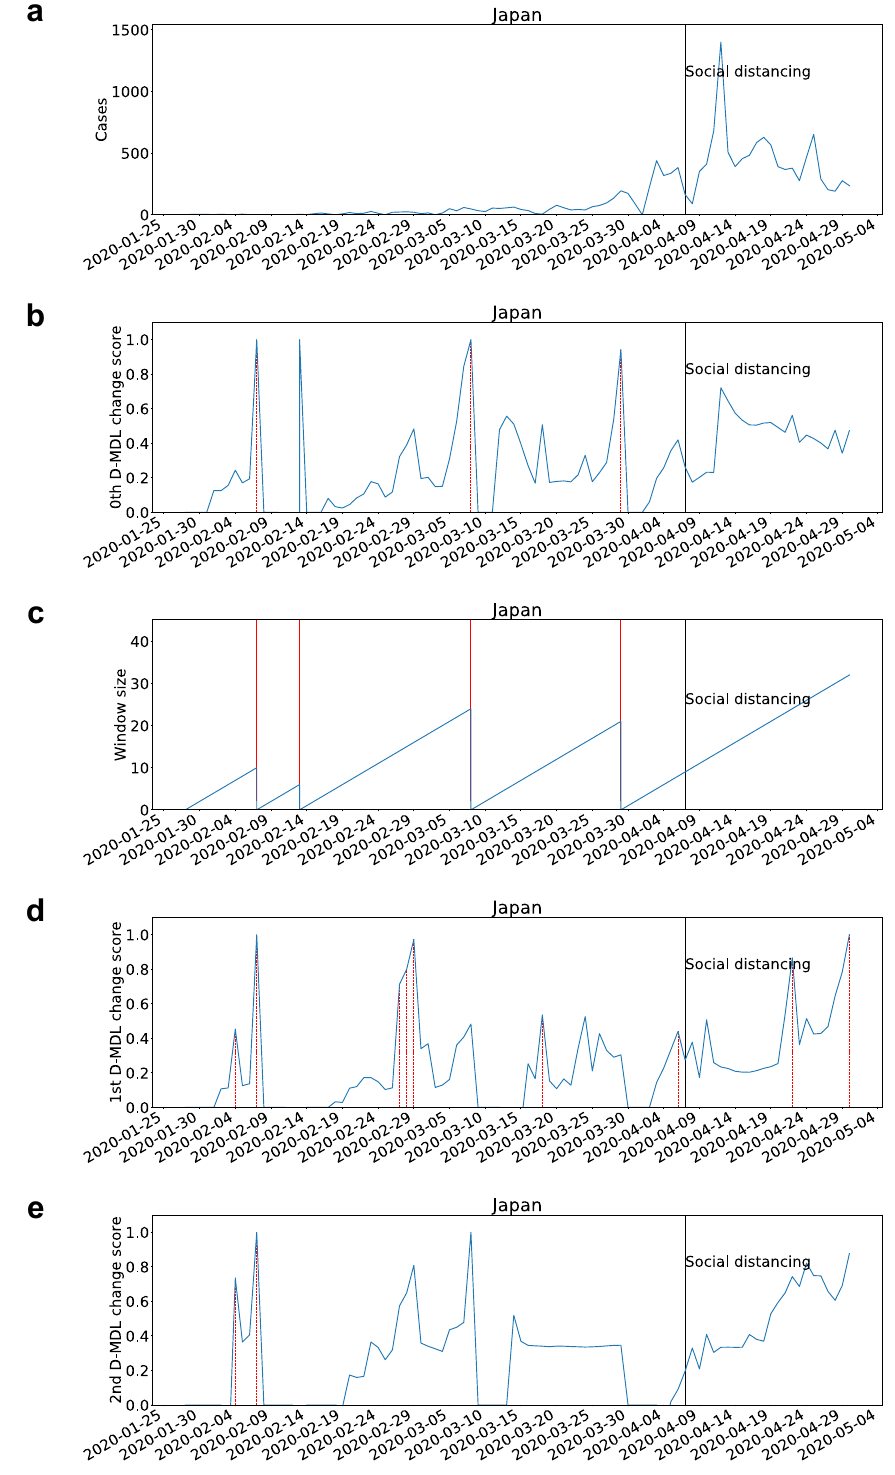
Figure 1. The results for Japan with the Gaussian modeling. The date on which the social distancing was implemented is marked by a solid line in black. ( a ) The number of daily new cases. ( b ) The change scores produced by the 0th D-MDL where the line in blue denotes values of scores and dashed lines in red mark alarms. ( c ) The window sized for the sequential D-MDL algorithm with adaptive windowing where lines in red mark the shrinkage of windows. ( d ) The change scores produced by the 1st D-MDL. ( e ) The change scores by the 2nd D-MDL. In all figures the negative scores are